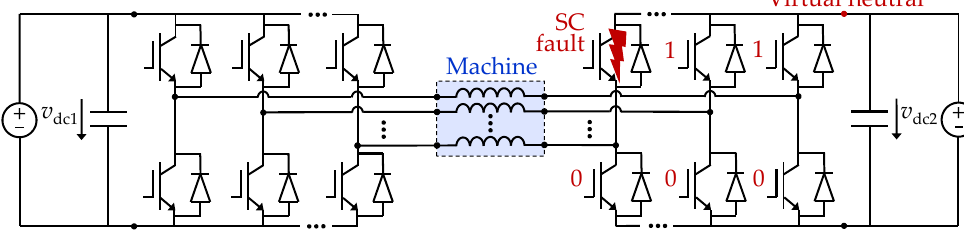
Figure 18. Tolerance to a switch SC by creating a virtual neutral point through an HB VSC in a drive based on open-end windings supplied by two HB